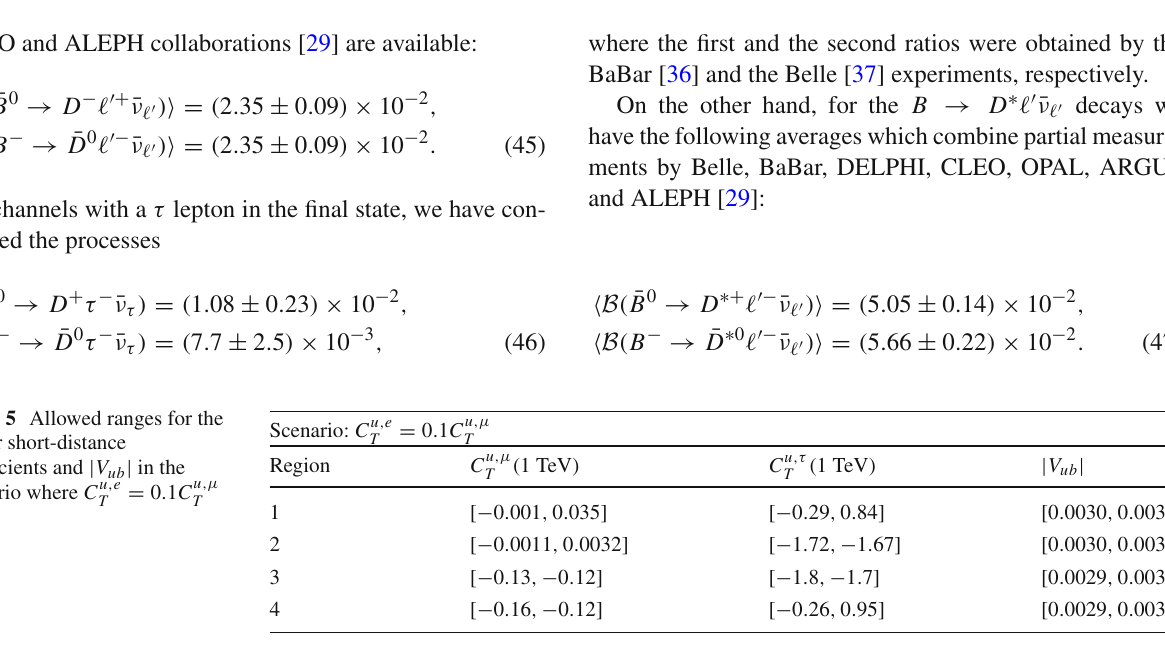
,μ or C u ,τ , in T T